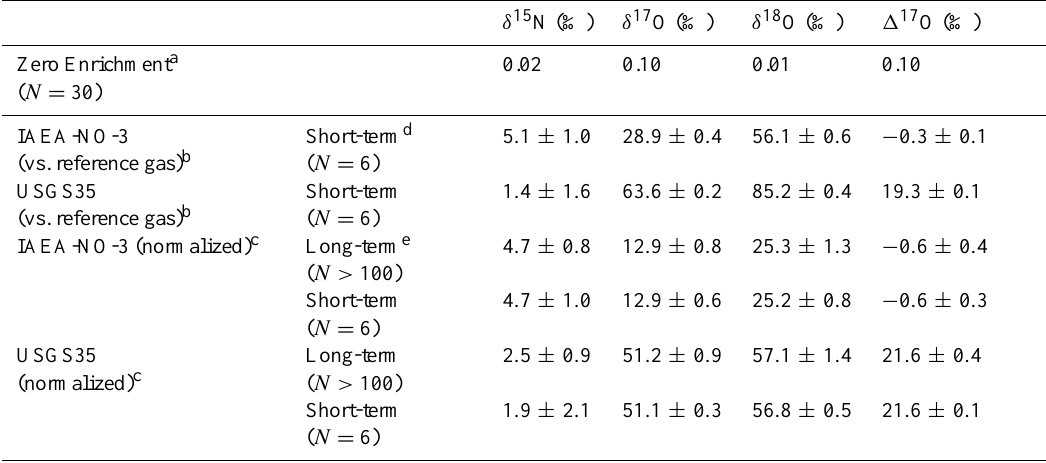
Table 1. Uncertainties of replicate measurements of reference gases and standards using the bacterial denitrifier method (Kaiser et al., 2007) at the University of Washington